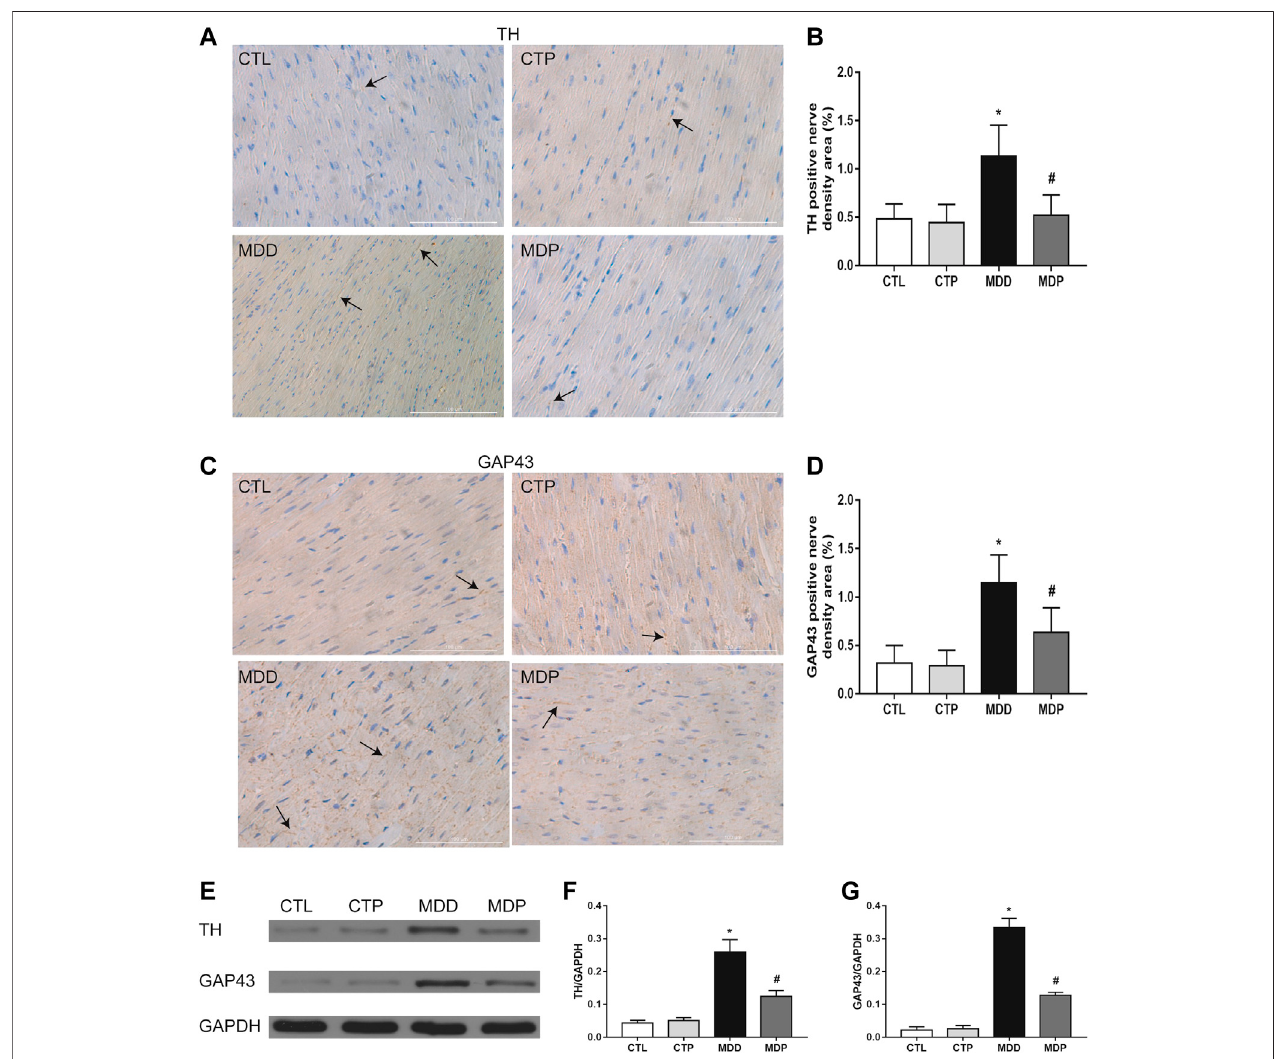
FIGURE 7 | Ventricular autonomic neural remodeling. (A,B) Typical staining examples and quantitative analysis of TH in LV, respectively (original magni fi cation: × 400). (C,D) Typical staining examples and quantitative analysis of GAP43 in LV, respectively (original magni fi cation: × 400). n (cid:1) 7 per group. (E – G) Immunoblotting and expressionratioofTHandGAP43,respectively.n (cid:1) 7pergroup.* p < 0.01vs.CTL;# p < 0.01vs.MDD.TH,tyrosinehydroxylase;GAP43,growthassociatedprotein-43; LV, left